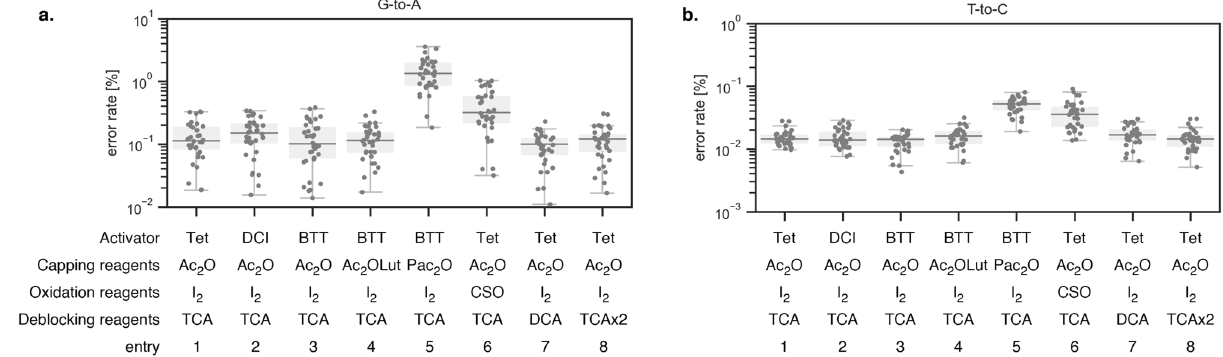
Figure 6. Synthetic condition dependency of error rates of G-to-A and T-to-C substitutions. The data were obtained from three independently synthesized oligonucleotides. ( a ) G-to-A substitutions. ( b ) T-to-C